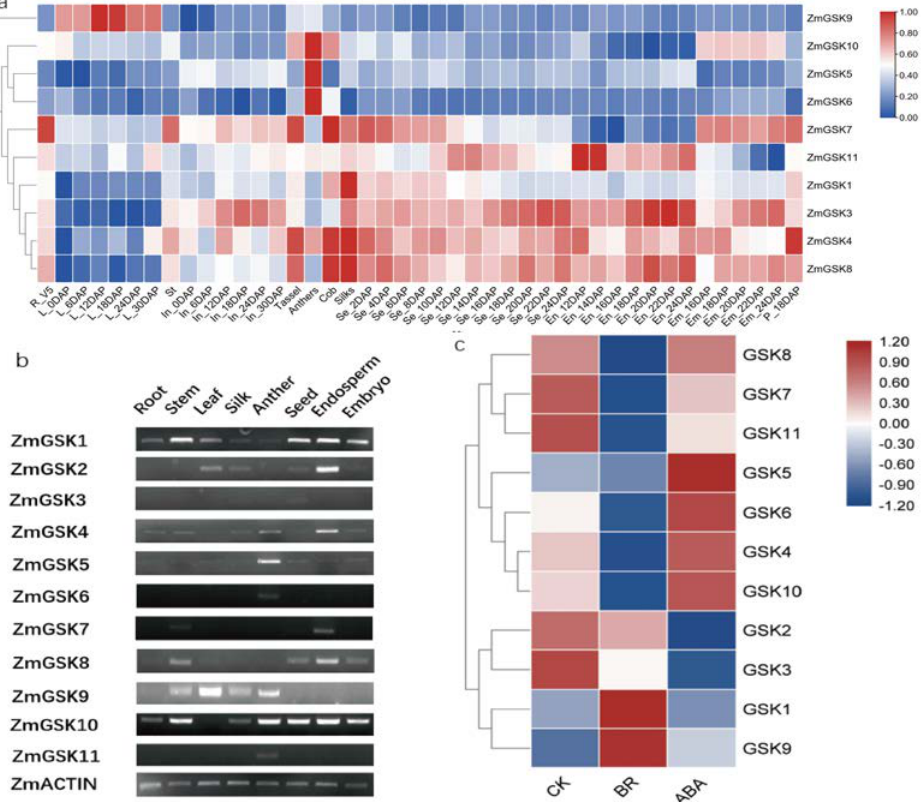
Figure 5. Expression patterns of ZmGSK genes. ( a ) Phylogenetic tree based on the MaizeGDB database. ZmGSK2 is not in the tree because it was not found in the database. The tissues and developmental stages examined are indicated at the bottom of the heat map. The log2 − transformed FPKM values were utilized to generate the heat map. (R: Root; L: Leaf; St: Stem; In: Internode; Se: seed; En: Endosperm; Em: Embryo) ( b ) Expression of ZmGSK genes in different tissues. ( c ) The relative expression levels of ZmGSK genes in 9 − 10 DAP seeds under normal, BR, and ABA conditions. The relative expression levels of the ZmGSK genes in comparison with that of the ZmTXN gene were used to draw the figure in TBtools software. The red and blue colors reflect log-transformed data with normalization.